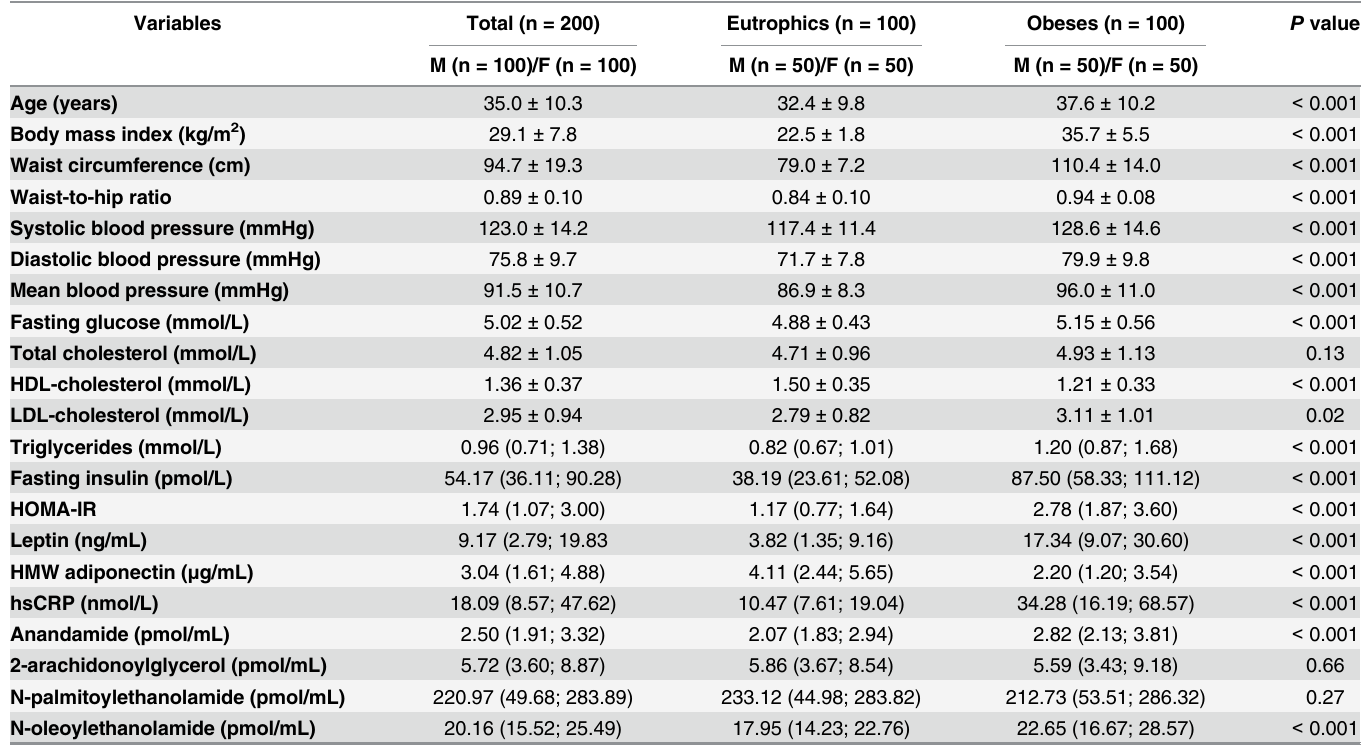
Table 1. Characteristics of the study population.